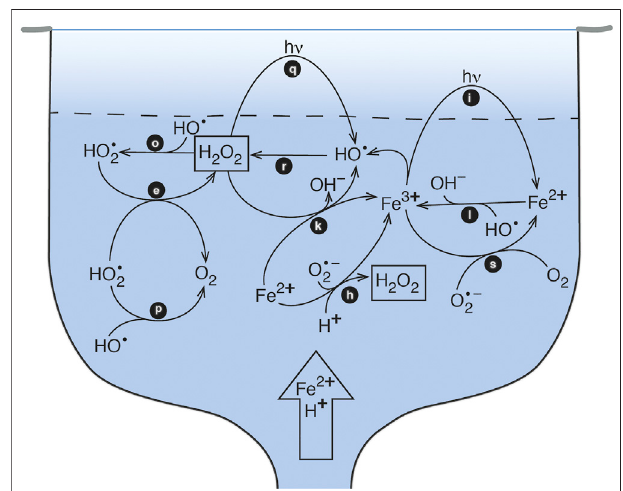
FIGURE 1 | Schematic model of Fe-cycling in a pool-type acid-sulfate- chloride-type hot spring. The vent source supplies Fe(II) and acid to the pool, at whichpoint the Fe(II) isoxidized tothephotochemically active form ofFe(III). Photoreduction ofFe(III) leads to production ofHO forms H 2 O 2